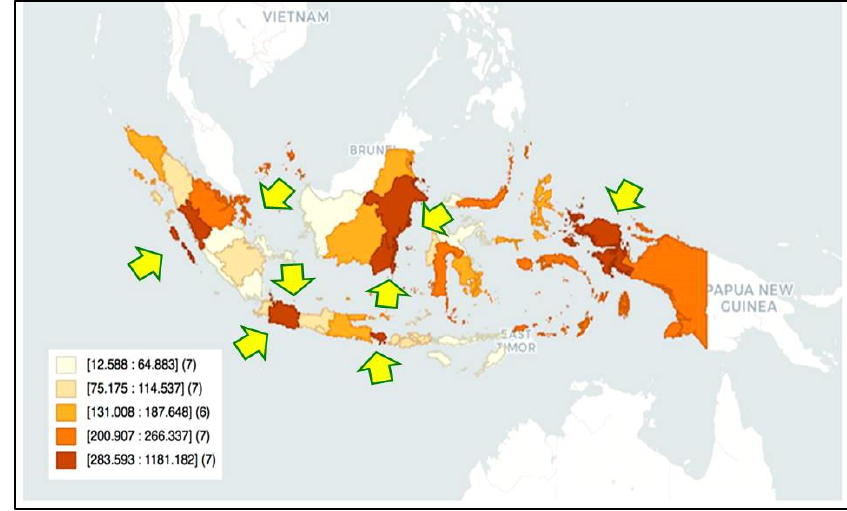
Figure 4. Lockdown focus in Indonesia (Adapted from Sevindik et al. (2021)